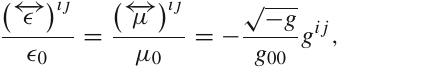
Fig. 1 Scheme of the method employed to discretize a null geodesic pathviastraightsegmentsandtheSnell’srefractionlaw.Thecoloredcir- cular regions represent a generic GSIM equivalent spacetime described in an isotropic coordinate system through the EM-analog model used in this work. The figure shows how a null geodesic in the inhomogeneous media is approximated by using discrete steps when a photon moves from a region of low refractive index towards a region of high refractive index